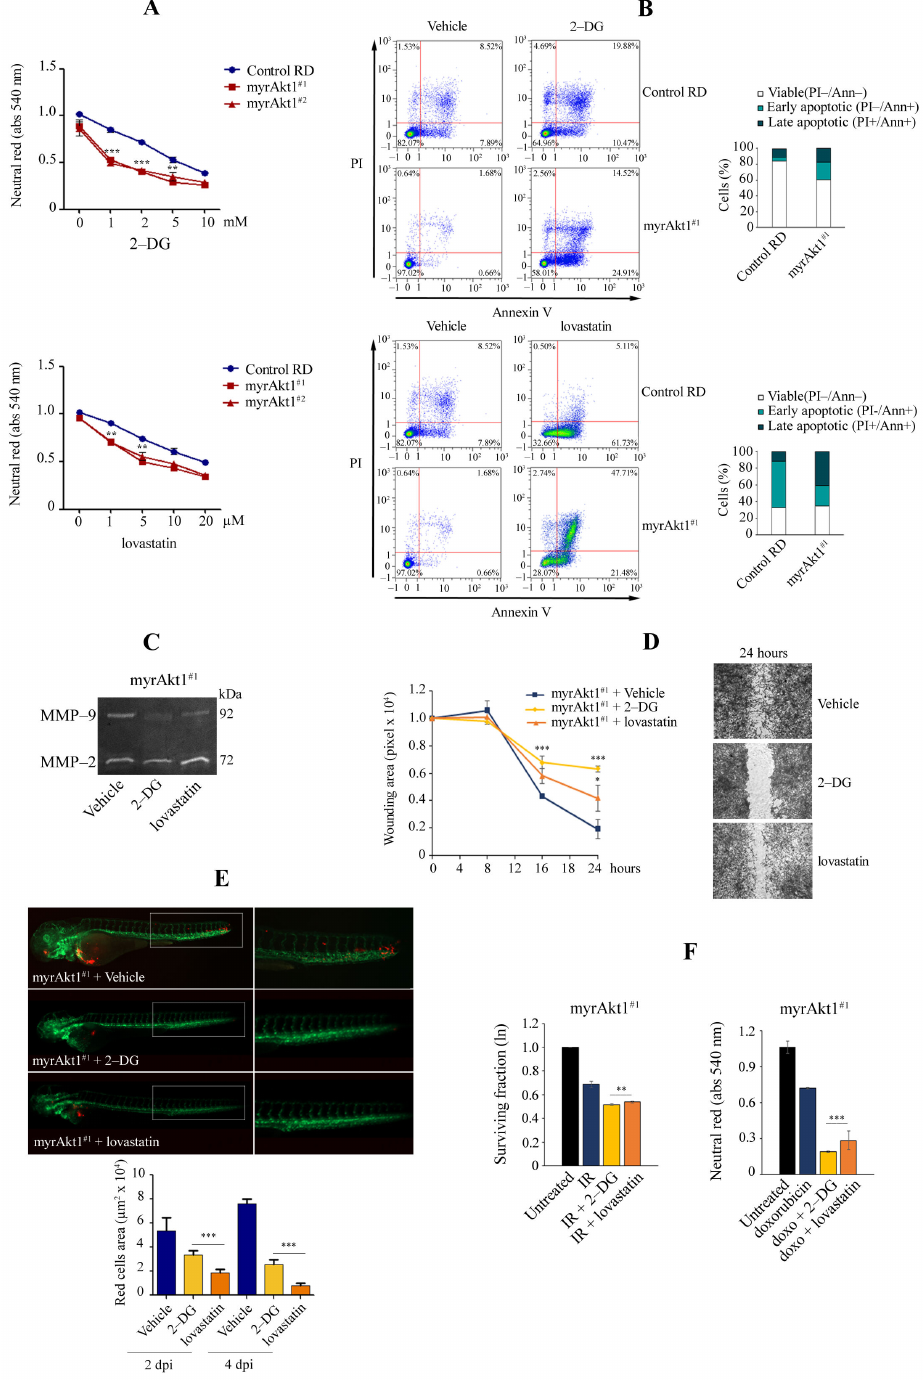
Figure 4. Effects of 2-DG and lovastatin on cell survival, cell dissemination, and radio- and